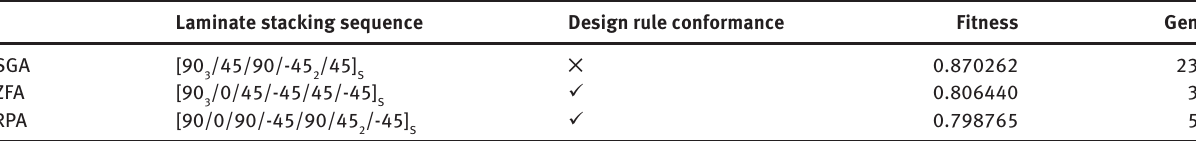
Table 4 Optimal results for rule 1.